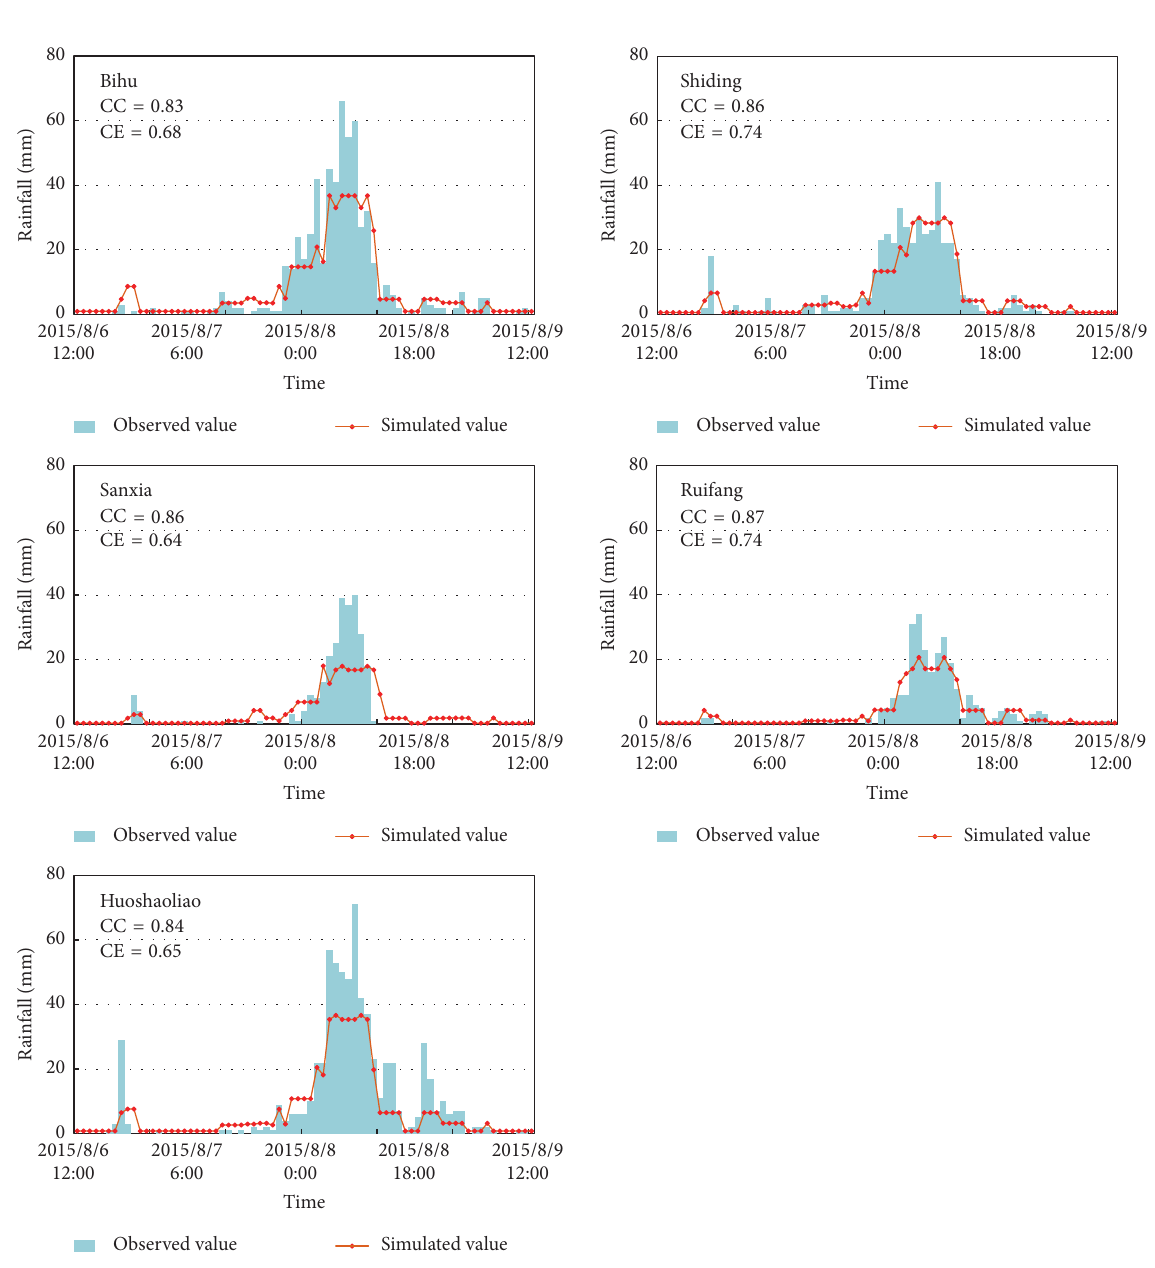
Figure 4: Results of hourly rainfall forecast during Typhoon Soudelor (2015). Table 4: Coefficients of correlation and efficiency during Typhoon Soudelor (2015).